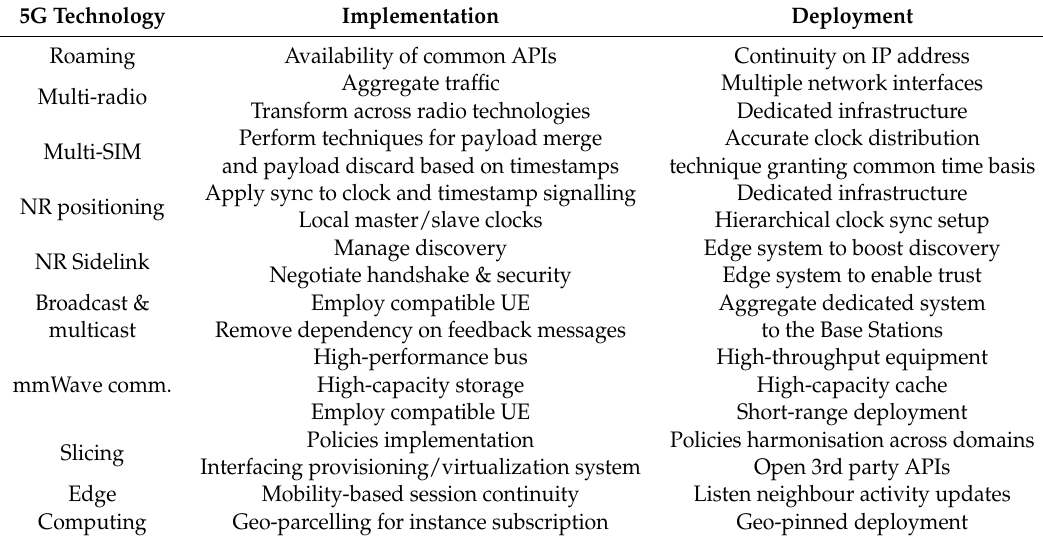
Table 5. Implementation and deployment aspects of 5G technologies in cross-border CAM